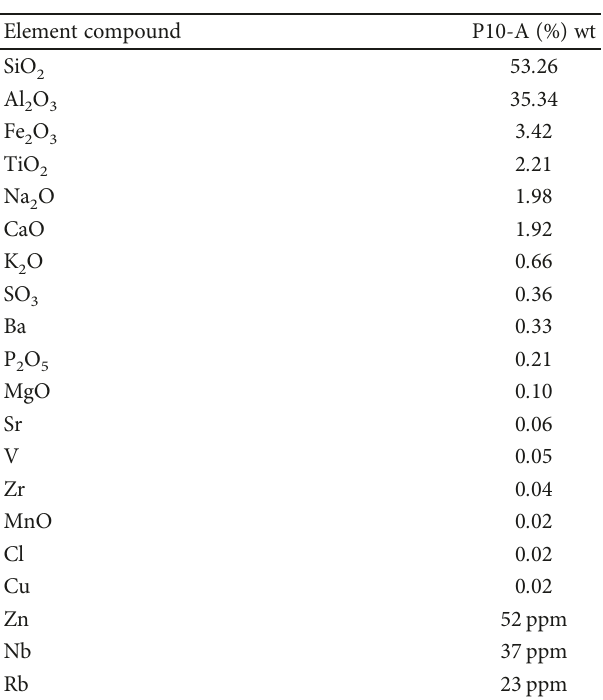
Table 8: XRF analysis of La Mina samples (a) P2-B, (b) P3-B, and (c)